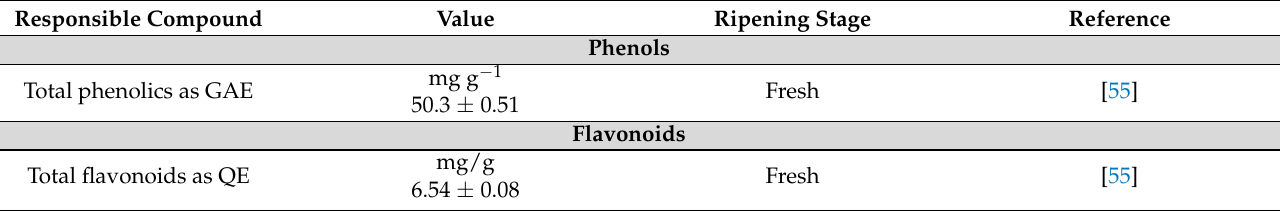
Table 11. Antioxidant compounds of Mespilus germanica L. flower